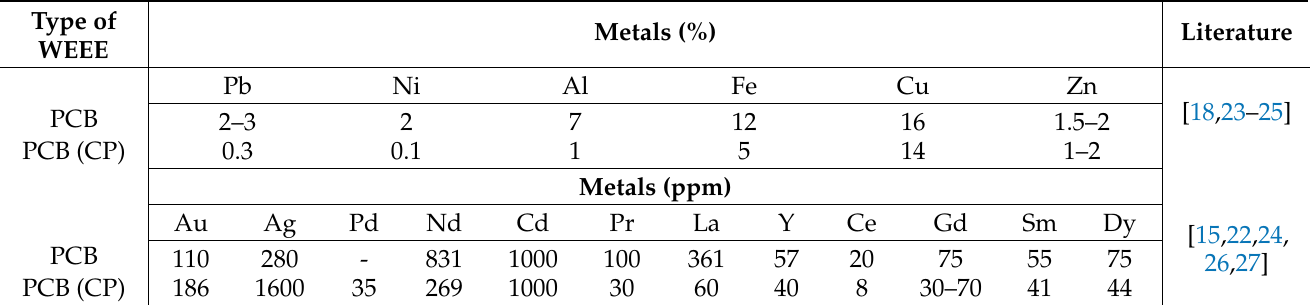
Table 2. PCB composition derived from personal computer and cell phone (CP) waste.